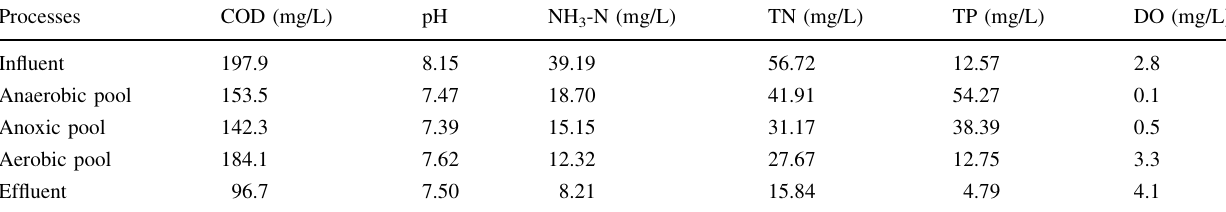
Table 1 Results of major indicators in processes